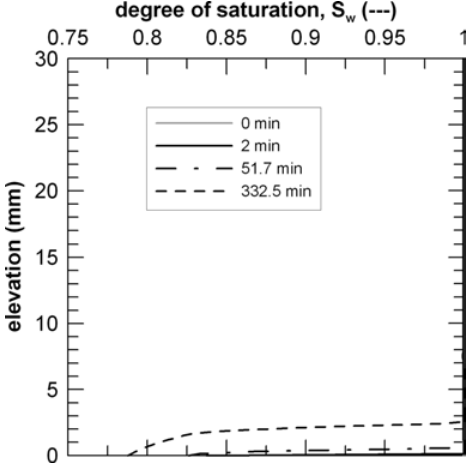
Fig. 9 – Electrokinetic filtration test: isochrones of the degree of saturation computed for